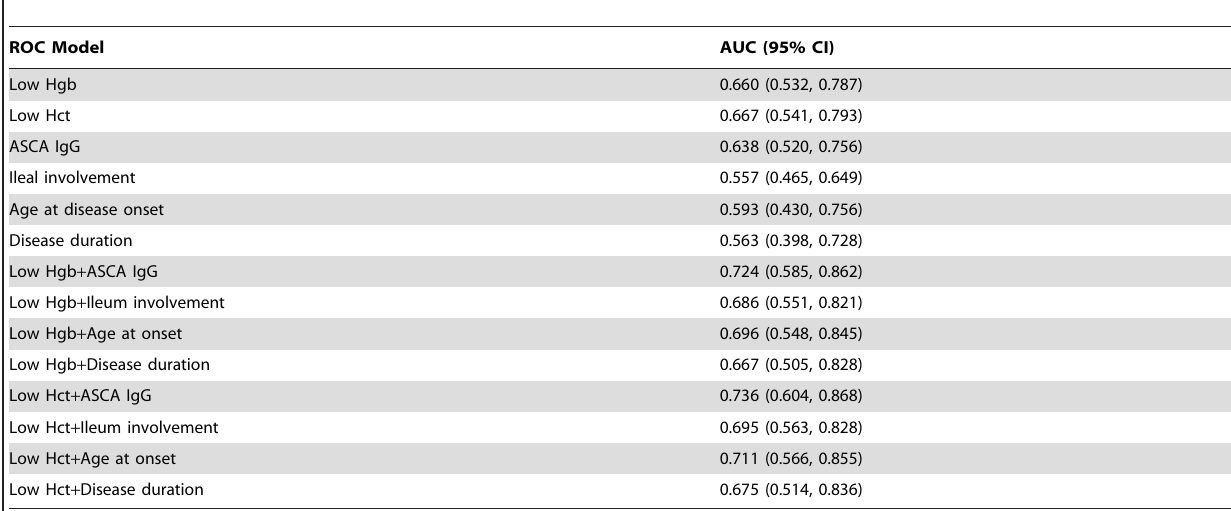
Table 5. Comparison of Hemoglobin and Hematocrit for the Prediction of Complicated Crohn’s disease with ASCA IgG and Clinical